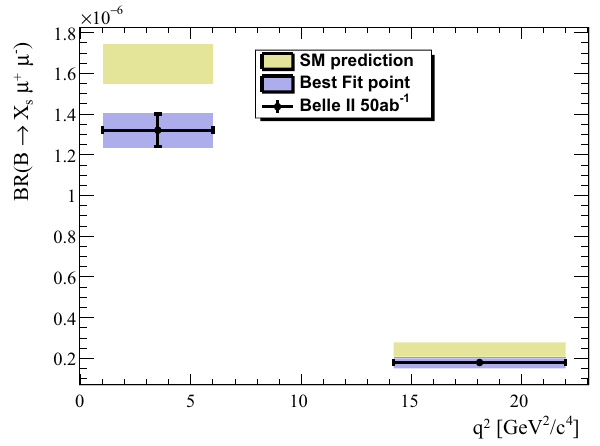
Fig. 6 Predicted exclusive branching fraction BR ( B → X μ + μ − ) in the Standard model (yellow shading) and in our best-fit model (blue shading). We also show the expected sensitivity of Belle II after it has collected50ab − 1 ofdata[91],assumingthatthecentralmeasuredvalues are equal to our best-fit